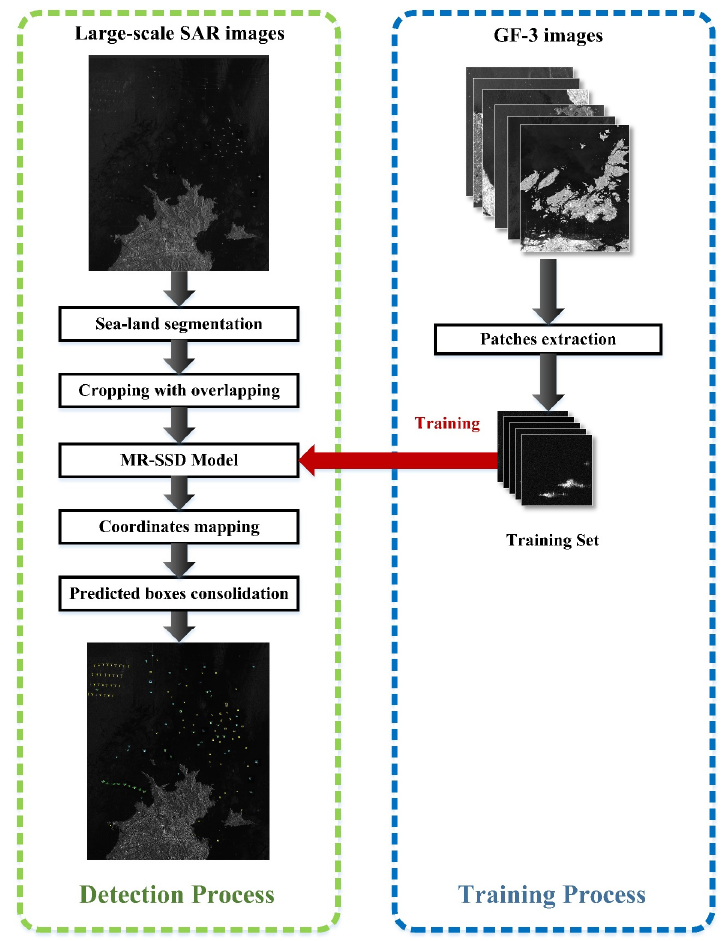
Figure 4. The whole workflow of marine target detection in large-scale images.